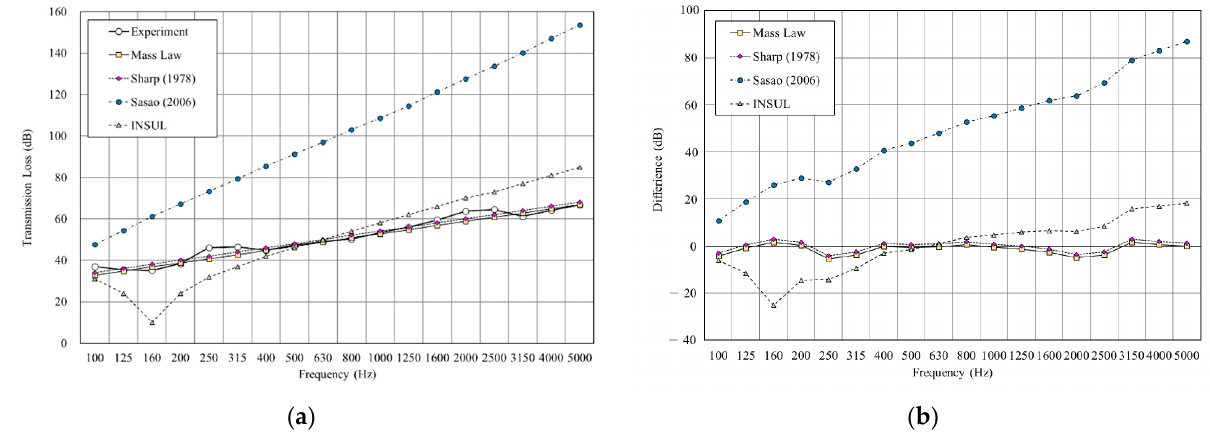
Figure 16. Comparison between experimental and predicted results of the double wall with 75 mm glass wool (B8). ( a ) The sound insulation performance of experiment and prediction. ( b ) The RMSE results of different prediction models.